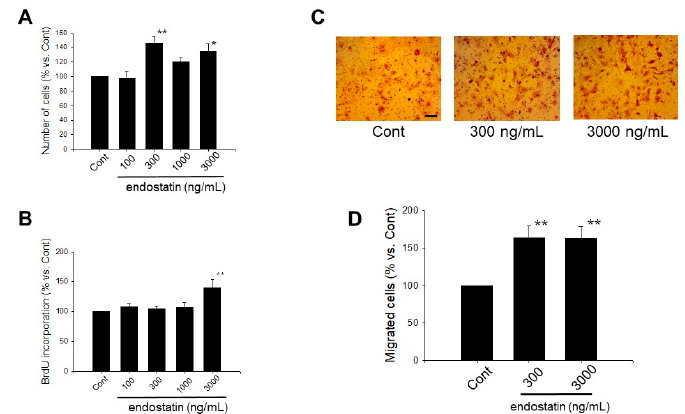
Figure 1. Endostatin induced proliferation and migration of myofibroblasts. ( A ) After myofibroblasts were grown to 30–50% confluence, they were stimulated with endostatin (100–3000 ng/mL) for 48 h. Control (Cont) was treated with a vehicle of endostatin (citrate-phosphate buffer). The number of viable cells was counted by a colorimetric method using a cell counting kit-8, and the normalized cell number relative to Cont are shown as mean ± standard error of the mean (S.E.M.) ( n = 5). *, p < 0.05, **, p < 0.01 vs. Cont; ( B ) After the cells were seeded at a density of 1 × 10 4 cells/well in a 96-well culture plate and starved (in 0.5% fetal bovine serum (FBS)), they were treated with endostatin (100–3000 ng/mL) or vehicle for 24 h. The cells were incubated with a bromodeoxyuridine (BrdU) reagent (20 µL/well) for 24 h, and BrdU incorporation was detected by a colorimetric method using an anti-BrdU antibody and tetramethylbenzidine solution. The normalized BrdU incorporation relative to Cont are shown as mean ± S.E.M. ( n = 8). **, p < 0.01 vs. Cont; ( C , D ) Migration of myofibroblasts was determined by a Boyden chamber assay. The cells at a density of 1 × 10 5 cells/100 µL serum free medium were seeded in the upper-chamber coated with 2% gelatin, and endostatin (300, 3000 ng/mL) or vehicle was treated in the bottom well for 24 h; ( C ) Representative pictures of Giemsa-stained migrated cells are shown. Scale bar: 100 µm. ( D ) The normalized migrated cell number relative to Cont are shown as mean ± S.E.M. ( n = 7). **, p < 0.01 vs. Cont.